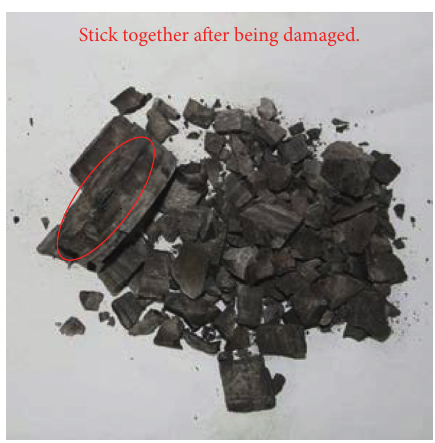
Stick together after being damaged.